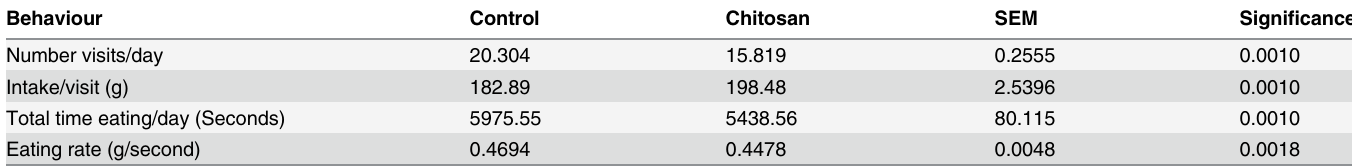
Table 4. Effect of prawn shell chitosan on feeding behaviour (D0-63) (least square means and SEM).